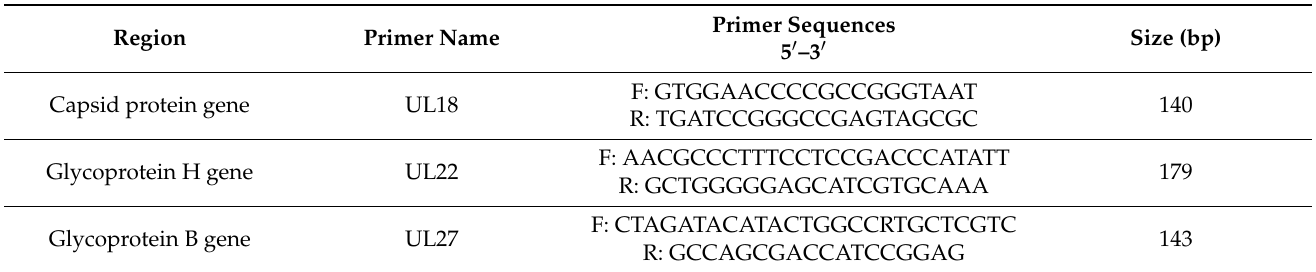
Table 1. Sequences of the oligonucleotide primers for amplifying the ChHV5 regions and expected amplification size